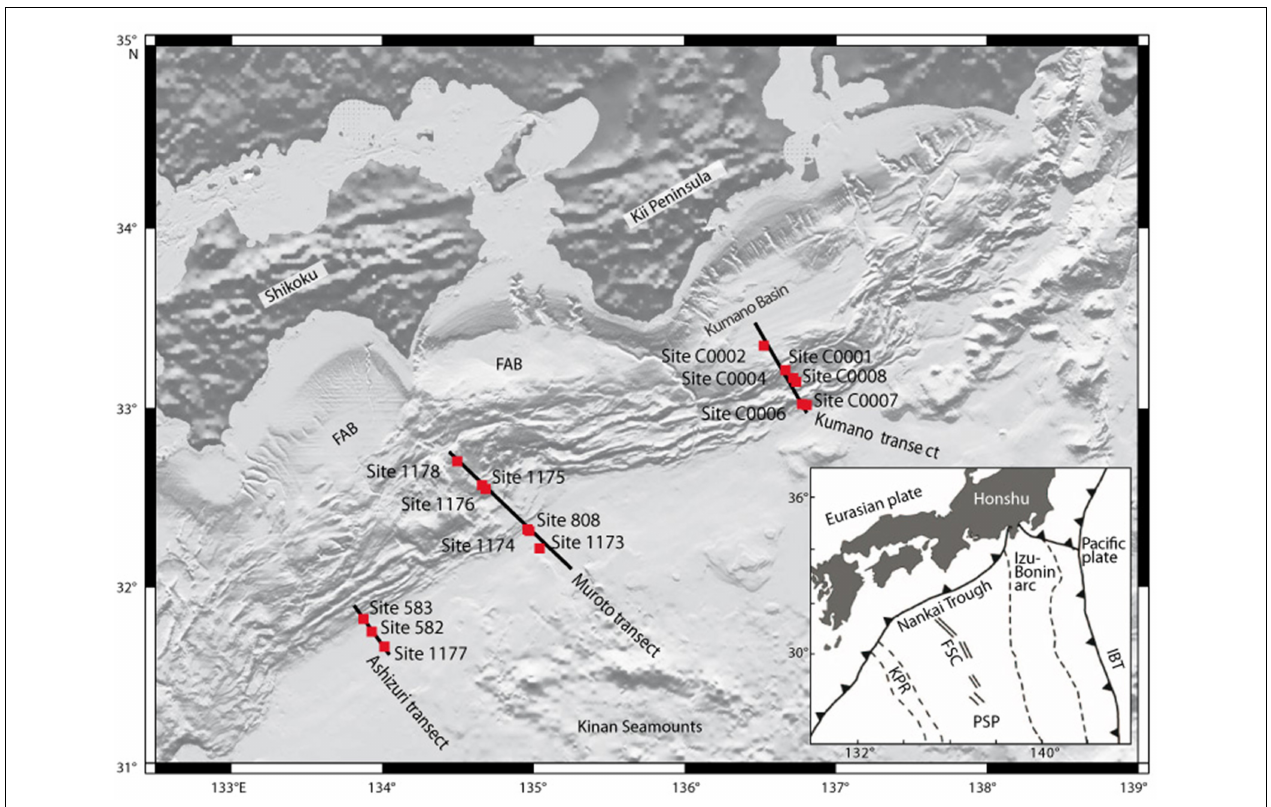
FIGURE 6 | Regional setting o northern Shikoku Basin and Nankai Trough region showing existing DSDP, ODP and IODP drilling transects. FAB, forearc basin; Inset, tectonic map showing plate